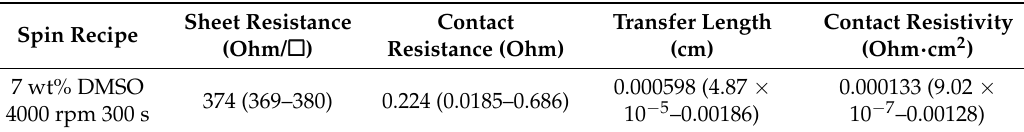
Table 2. The summary of values extracted from the TLM analysis of Ag contacts on PEDOT:PSS films. A 95% confidence range from the linear fit is shown in parenthesis.